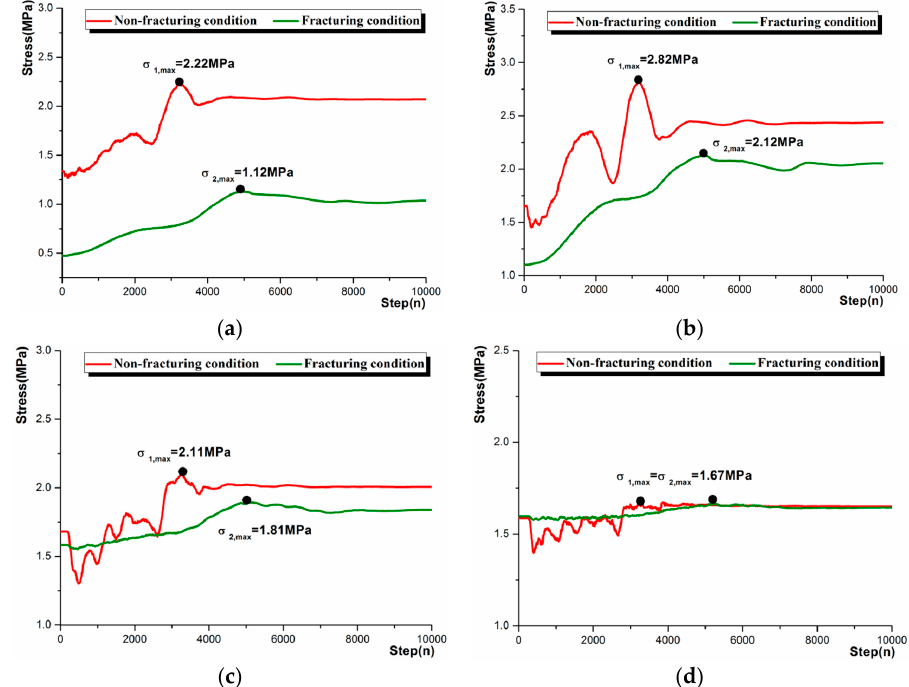
Figure 11. Vertical stress variation on the entry roof with respect to the calculation steps: ( a ) The monitoring point was 5 m above the roof; ( b ) The monitoring point was 10 m above the roof; ( c ) The monitoring point was 20 m above the roof; ( d ) The monitoring point was 30 m above the roof. The simulated results indicate that roof fracturing had a significant impact on the stress distribution and variations on the entry roof. The vertical stress was much smaller than that in the non-fracturing condition, especially when the measured point was within the fracturing-affected area (see Figure 11a,b). In addition, the fluctuation range was also smaller under fracturing conditions. This proves that the fracturing operation can prevent stress propagation from the gob roof to entry